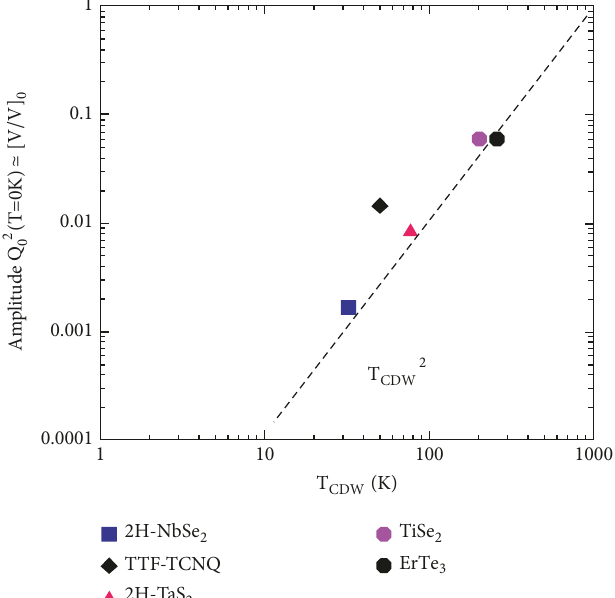
Figure 7: Color on line . Amplitudes of the square of the order parameter Q 2 0 at T = 0K, which is proportional to the values [ (cid:2) V / V ] 0 deduced from Figure 6, are reported as a function of T CDW . The solid line increases as 𝑇 2 𝐶𝐷𝑊